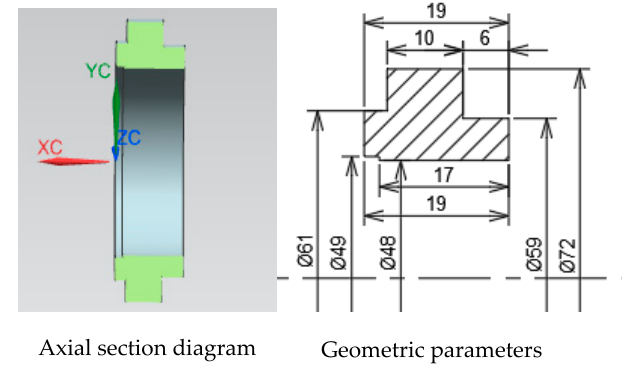
Figure 4. Rotating ring modeling diagram.